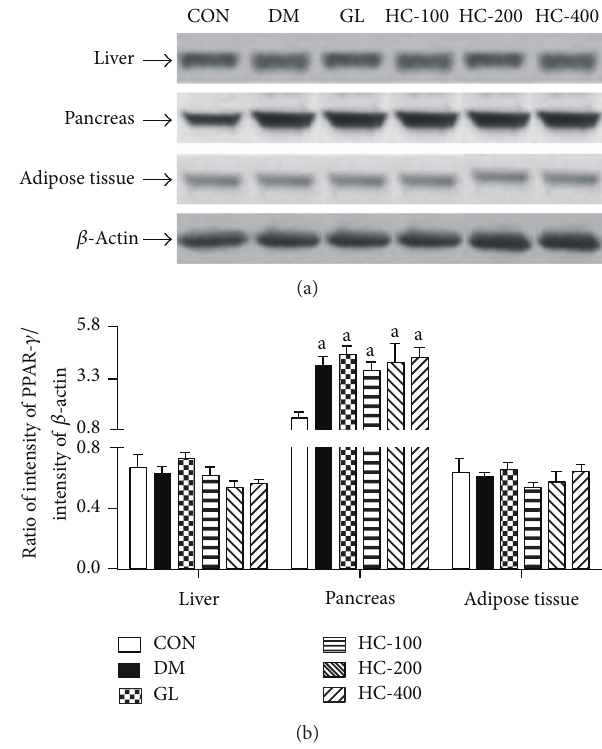
Figure 5: Effect of HC (100, 200 and 400 mg/kg) on STZ-induced changes in the levels of expression of PPAR- 𝛾 in liver, pancreas, and adipose tissues. The blots (a) are representative of PPAR- 𝛾 in liver, pancreas, and adipose tissues. The results in the histogram (b) are expressed as ratio of relative intensity of levels of protein expression PPAR- 𝛾 to 𝛽 -Actin. All values are mean ± SEM of three separate sets of independent experiments. a 𝑃 < 0.05 compared to normal control (one-way ANOVA followed by Tukey’s multiple comparison